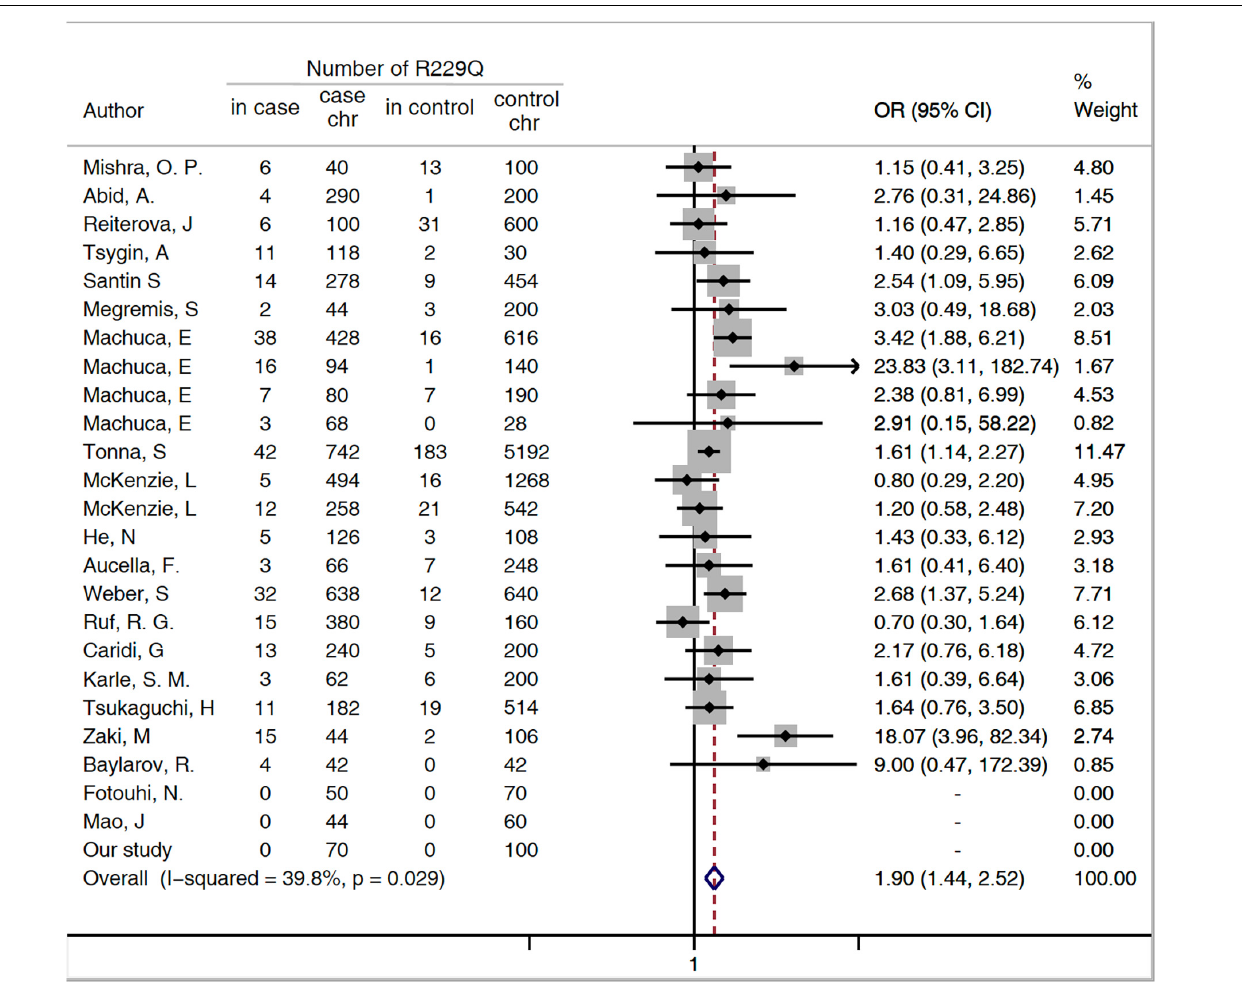
FIGURE 1 | Forest plots of meta-analysis of association between p.R229Q and FSGS/SRNS in the allelic model. Chr, chromosome; CI, confidence interval; OR, odds risk; SRNS, steroid-resistant nephrotic syndrome; and FSGS, focal segmental glomerular sclerosis.